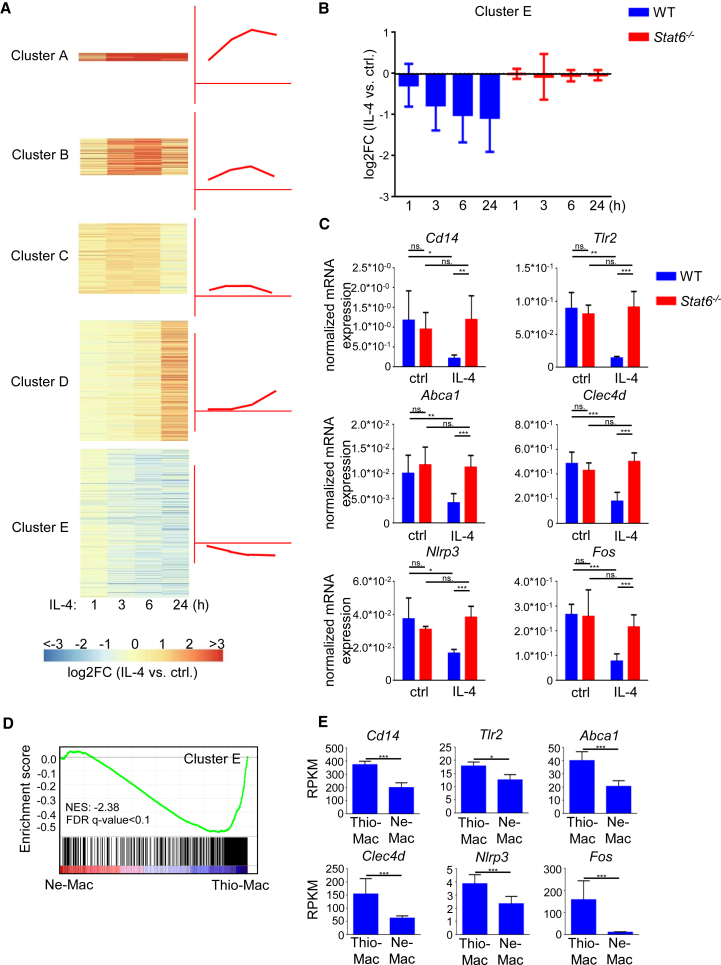
The IL-4-STAT6 Signaling Pathway Induced Gene Expression during Mouse Alternative Macrophage Polarization(A) Heatmap of IL-4-regulated (p value ≤ 0.05, FC ≥ 2) gene expression clusters in WT murine BMDMs. Data represent the average fold changes of four individual animals.(B) The average fold change from the IL-4-repressed gene cluster at the indicated time points following IL-4 stimulation in WT (n = 4) and Stat6−/− (n = 2) BMDMs. Error bars represent means ± SD.(C) RT-qPCR analysis of gene expression on a set of IL-4-repressed genes in WT and Stat6−/− BMDMs. BMDMs were treated with IL-4 for 6 hr. Data are representative of five individual animals per genotype from two independent experiments. ∗p < 0.05, ∗∗p < 0.01, ∗∗∗p < 0.001, ns, not significant change. Error bars represent means ± SD.(D) GSEA analysis of IL-4-repressed genes (in vitro) against a ranked list of genes regulated in the Brugia malayi-implanted mice-derived macrophages (Ne-Mac) compared to the intraperitoneal thioglycollate-administrated mice-derived peritoneal macrophages (Thio-Mac).(E) Expression of IL-4-repressed genes in the Brugia malayi-implanted mice-derived macrophages (Ne-Mac) and the intraperitoneal thioglycollate-administrated mice-derived peritoneal macrophages (Thio-Mac). Reads per kilobase per million values (RPKM) are presented as the mean and SD of three individual animals per group quantified by RNA-seq. ∗p < 0.05, ∗∗p < 0.01, ∗∗∗p < 0.001.